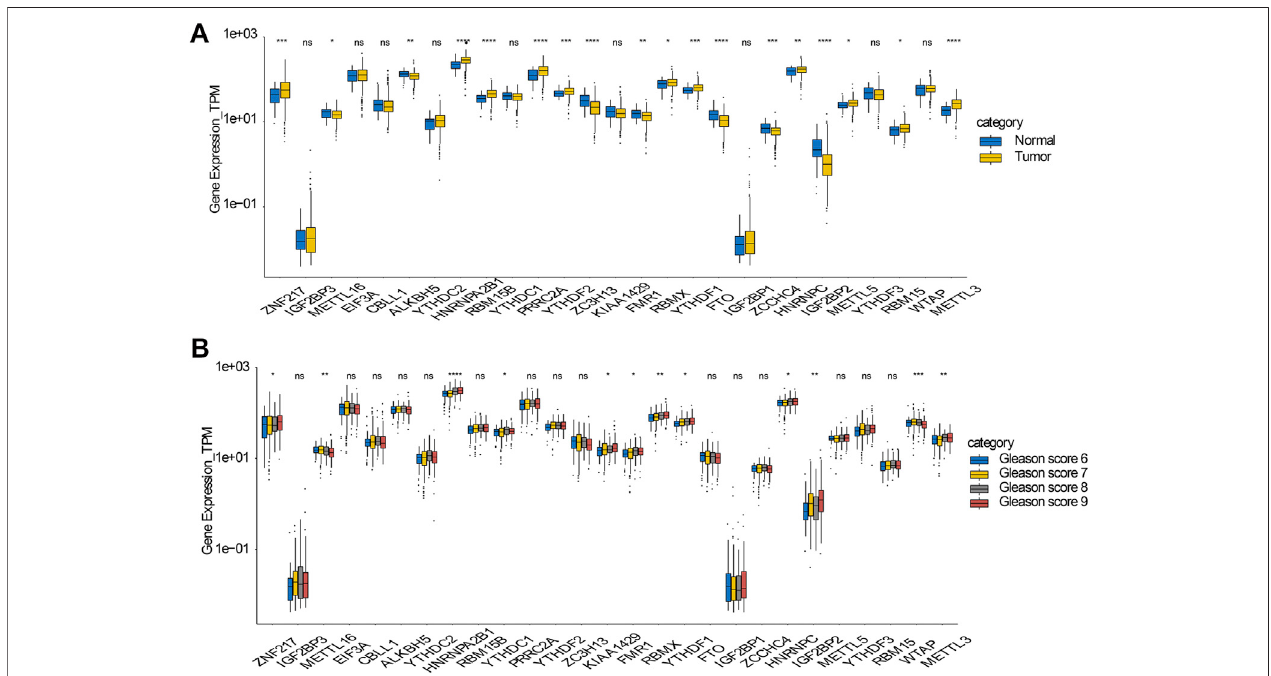
FIGURE 1 | Expressions and genetic variations of m6A regulators in prostate cancer (A) Boxplot showing the m6A regulators with highly signi fi cant difference in their RNA expression between normal and tumor samples (B) Boxplot showing the m6A regulators with highly signi fi cant difference in prostate cancers with different Gleason